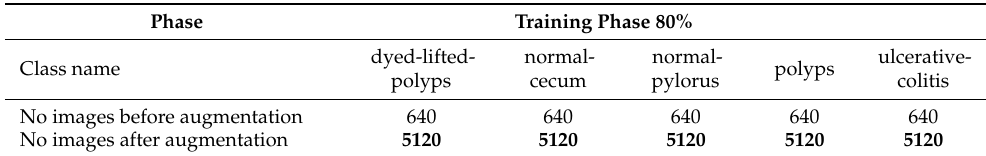
Table 4. Seting parameter options for GoogLeNet and AlexNet models.